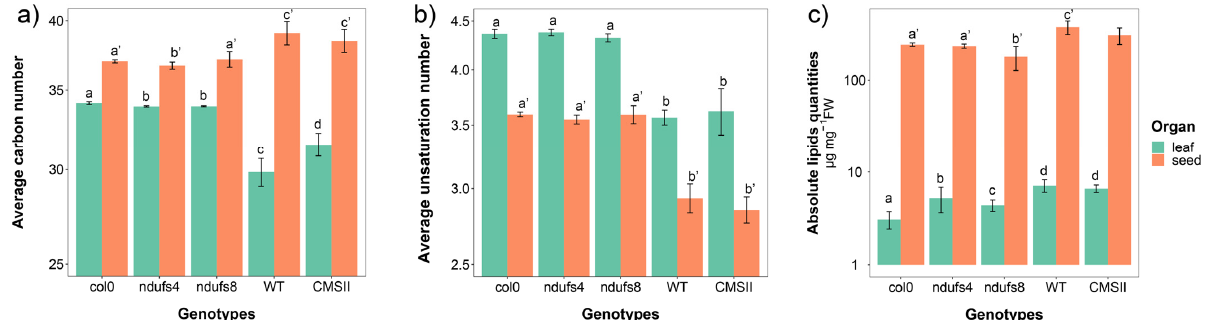
Figure 1. Chain length and unsaturation number in esterified fatty acid chains and absolute lipid content in leaves and seeds in wild-type and CI mutants CMSII (tobacco) and ndufs4 and ndufs8 (Arabidopsis). ( a ) Average chain length (sum of the two esterified fatty acids) across all lipid families; ( b ) average unsaturation number in esterified fatty acids number across all lipid families; ( c ) absolute content in total lipid ( µ g mg − 1 FW). Letters stand for statistical classes (one-way ANOVA) both in leaves (nonprimed letters) and seeds (primed